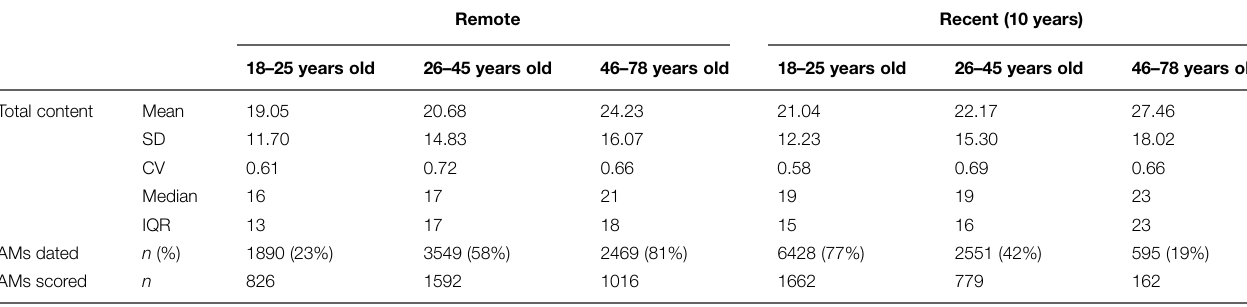
FIGURE 1 | Temporal distributions of autobiographical memories (AMs). Participant age at the time of a recalled event was computed as the midpoint of its assigned temporal bin (see Materials and Methods); the proportions of AMs retrieved across the life span are plotted according to subject age at the time of the event ( n : number of dated AMs). Younger subjects displayed the greatest retention of recent AMs, which gradually decreased with increasing age. The reminiscence bump TABLE 2 | Autobiographical memory content and retrieval across life periods and age groups.